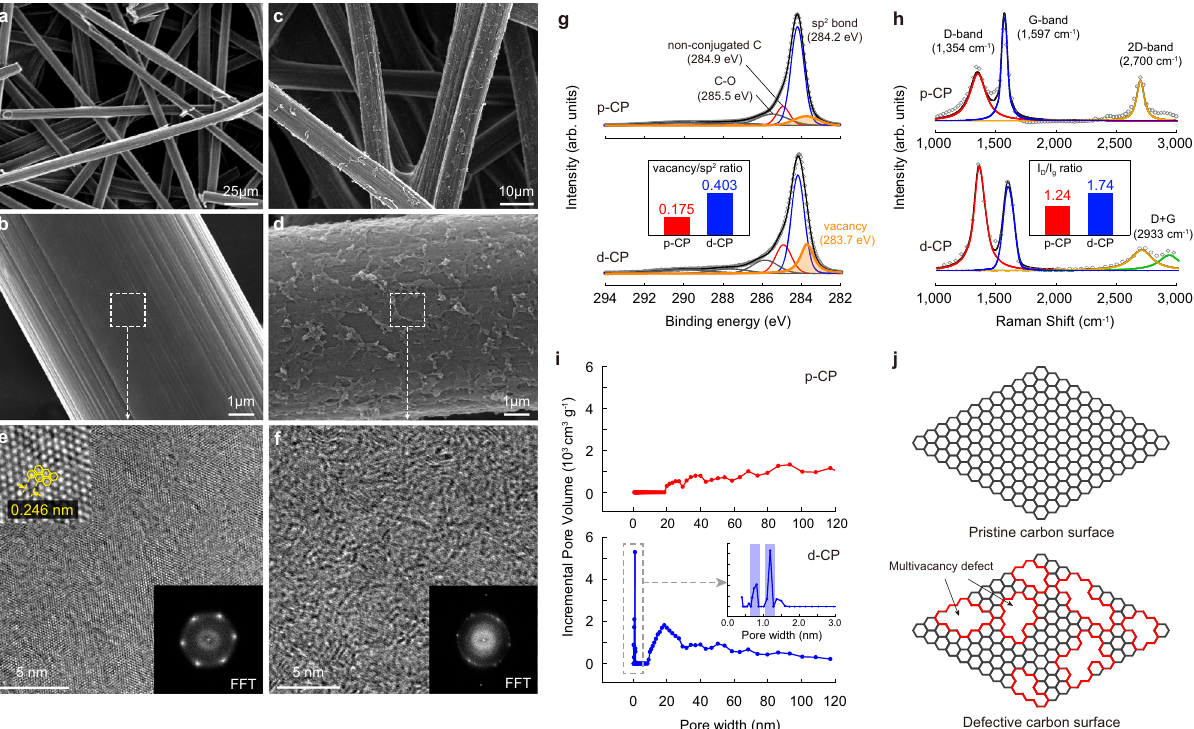
Fig. 2 Atomistic structure of the defective carbon layer. a – d SEM images of p-CP ( a , b ) and d-CP ( c , d ). e , f HR-TEM images and corresponding FFT patterns for p-CP ( e ) and d-CP ( f ). g C 1 s HR-XRS spectra for p-CP and d-CP. The binding energy in XPS was calibrated with the C 1 s sp 2 peak at 284.2 eV. (Inset: Comparison of the vacancy/ sp 2 ratio determined by dividing the area of the vacancy peak by that of the sp 2 peak between p-CP and d-CP). h Raman spectra for p-CP and d-CP. (Inset: Comparison of I D / I G ratio calculated by dividing the area of the D-band by that of the G-band between p-CP and d-CP) i BJH pore size distribution analysis for p-CP and d-CP. Inset is the magni fi ed micropore region for d-CP. j Schematic illustrations of the atomistic structure of the p-CP and d-CP surfaces. The red line indicates the MV defects of region is a general characteristic of micropores (<2 nm). In the BJH pore size distribution analysis, d-CP exhibited an intense signal at 1.2 nm and a weak signal at 0.9 nm, which corresponded to 8 and 6 missing carbons, respectively. Based on the spectro- scopic and pore size analysis, d-CP can be characterized as an MV defect-enriched surface, as shown in Fig. 2j.